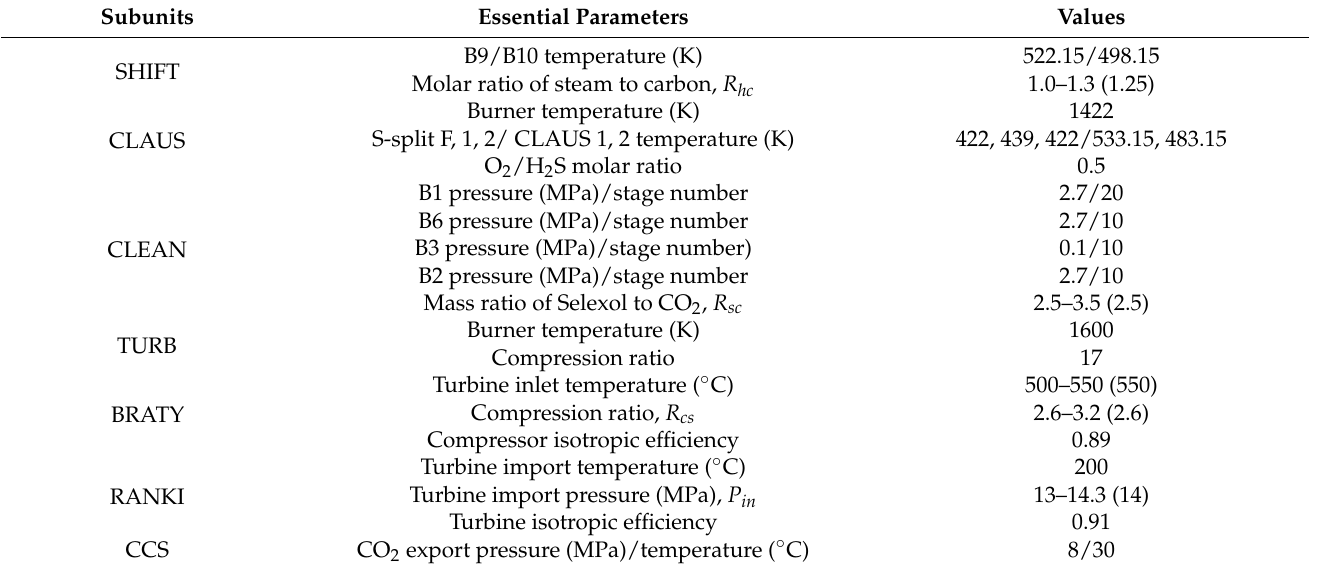
Table 11. Module operation parameters of the